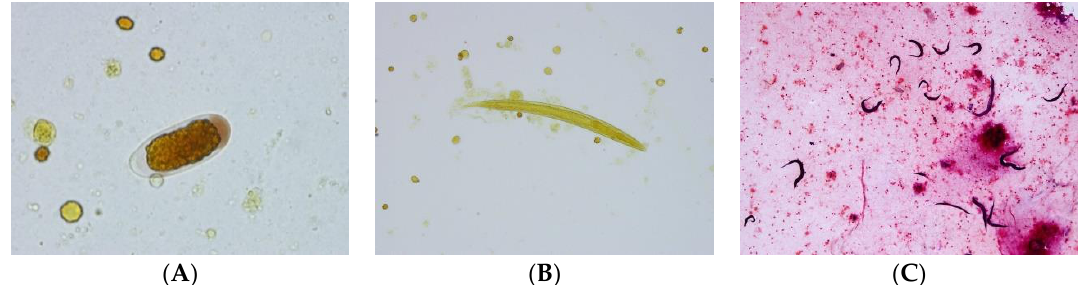
Figure 5. ( A ) Egg of parasite in CSF resembling the Trichostrongylus species (~50 × 20 µm). ( B ) larva of parasite in CSF resembling Strongyloides species (~250 µm). ( C ) Post-mortem brain tissue showing adult worms, larvae and eggs of the helminth (details and additional pictures in Reference 2).